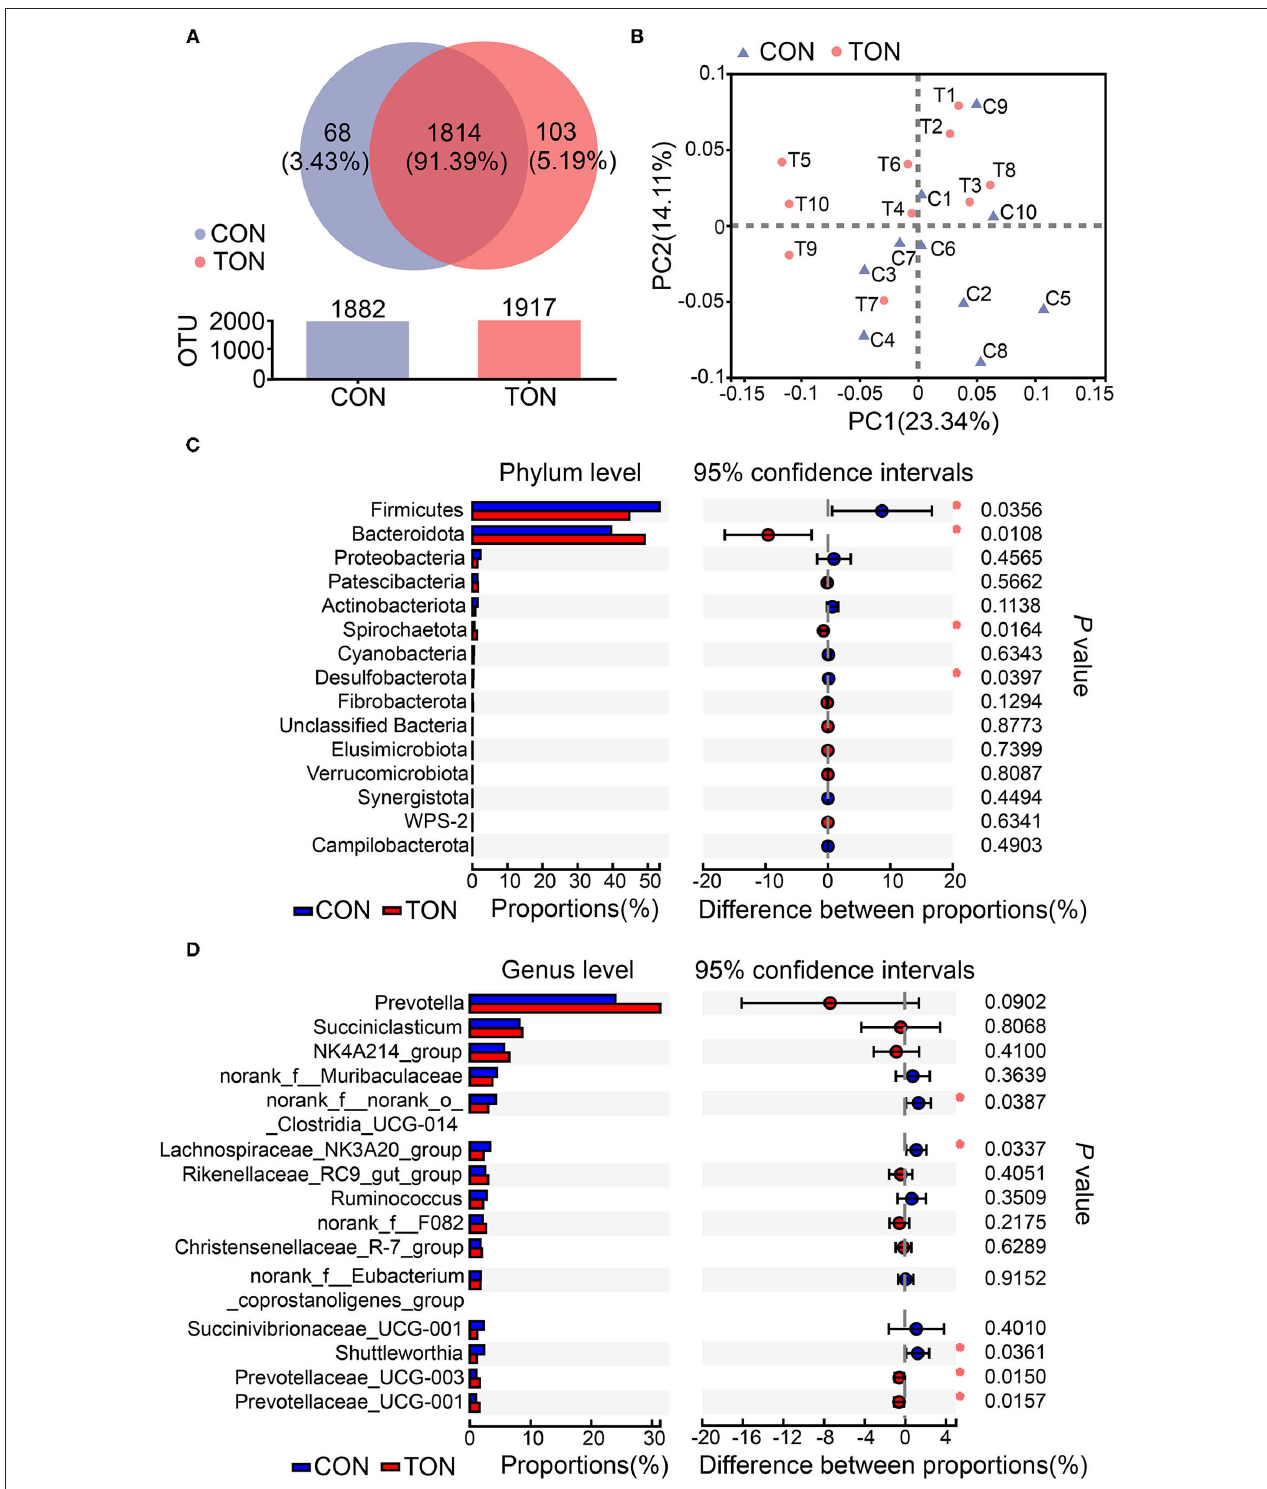
FIGURE 3 | (A) The Venn diagram of unique or shared OTUs in the TON and CON groups. Different colors represent different groups, the number in the overlapping part represents the number of species shared by multiple groups, and the number in the non-overlapping part represents the number of species unique to the corresponding group. (B) Principal component analysis (PCoA) of ruminal bacteria community in TON and CON groups. PC1, the first principal component; PC2, the second principal component. (C) Student’s t- test bar plot on Phylum level. (D) Student’s t -test bar plot on Genus level. TON, cows with tongue rolling behavior; CON, cows without abnormal